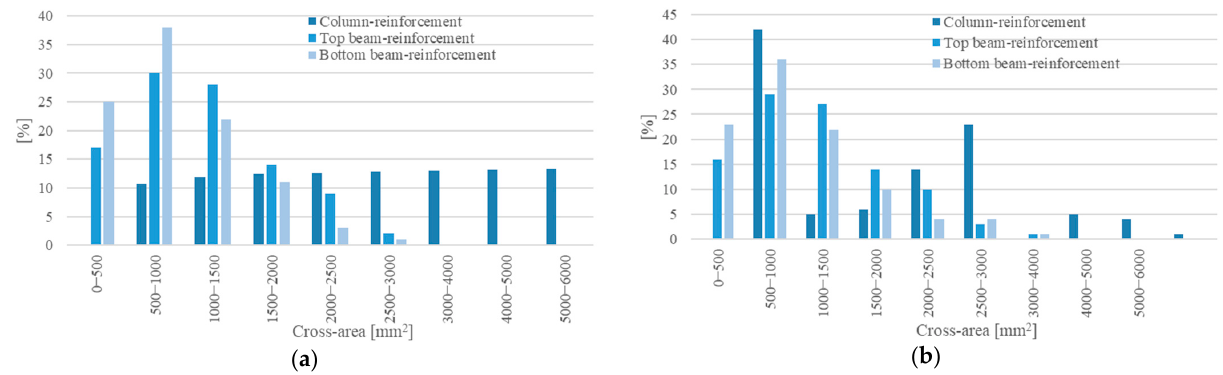
Figure 5. Geometrical characteristics of longitudinal reinforcements of RC frame elements (column and beams): ( a ) T-shaped RC joints, ( b ) X-shaped RC joints.